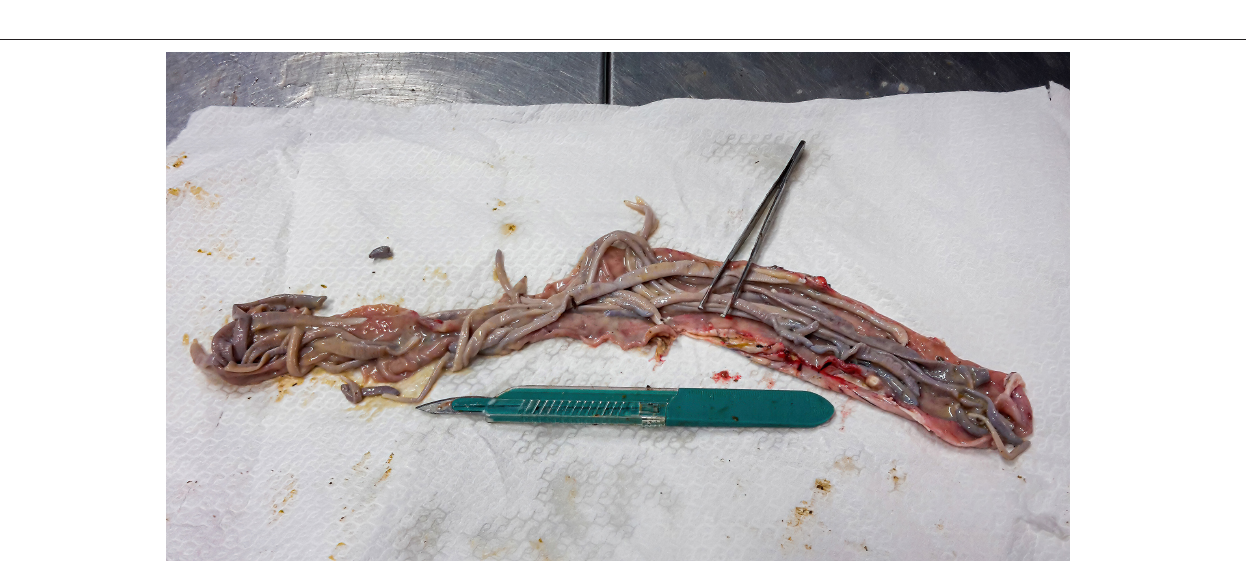
FIGURE 2 | Massive infestation of helminths ( M. hirudinaceus and A. suum ) in a young female feral pig.